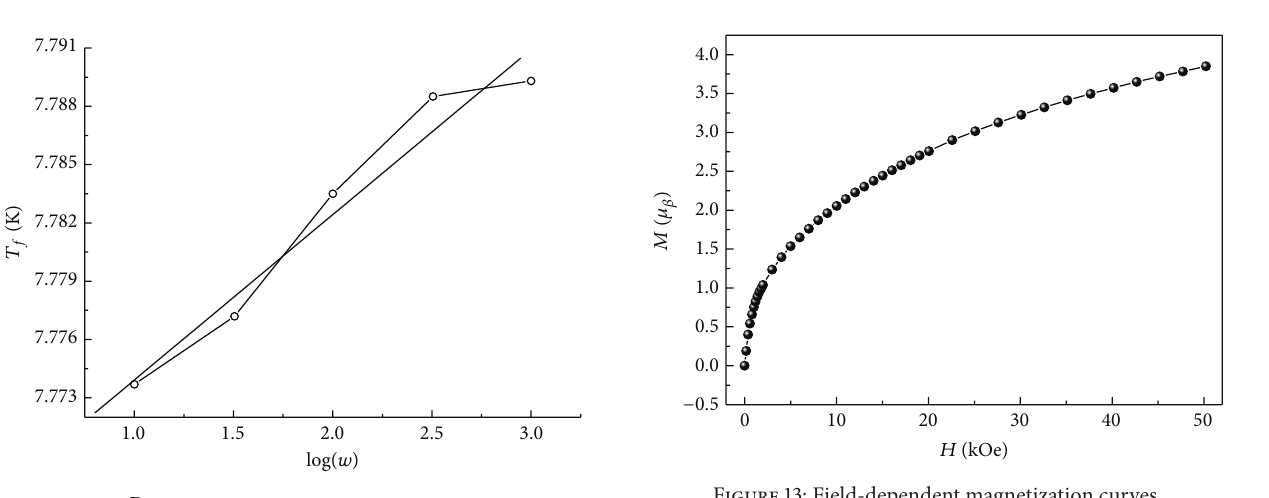
Figure 13: Field-dependent magnetization curves.